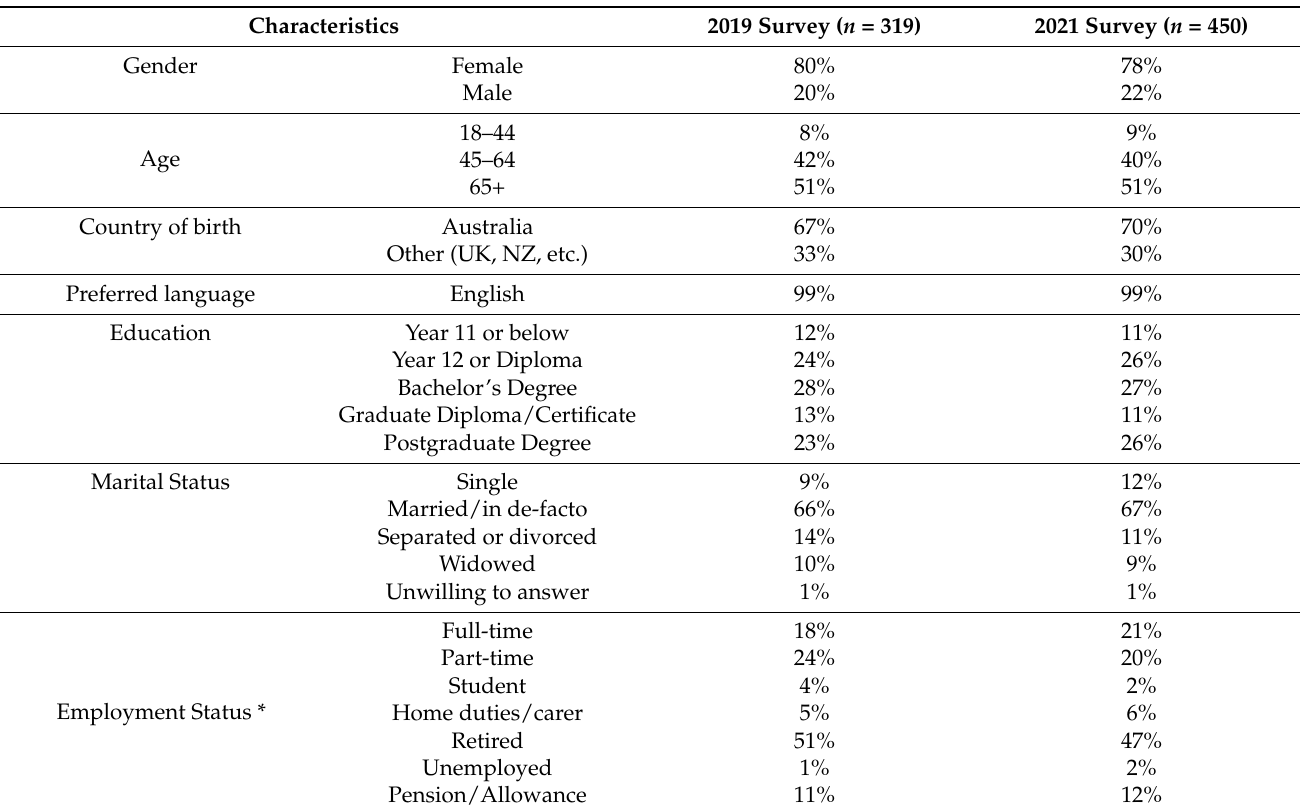
Table 2. Survey participants’